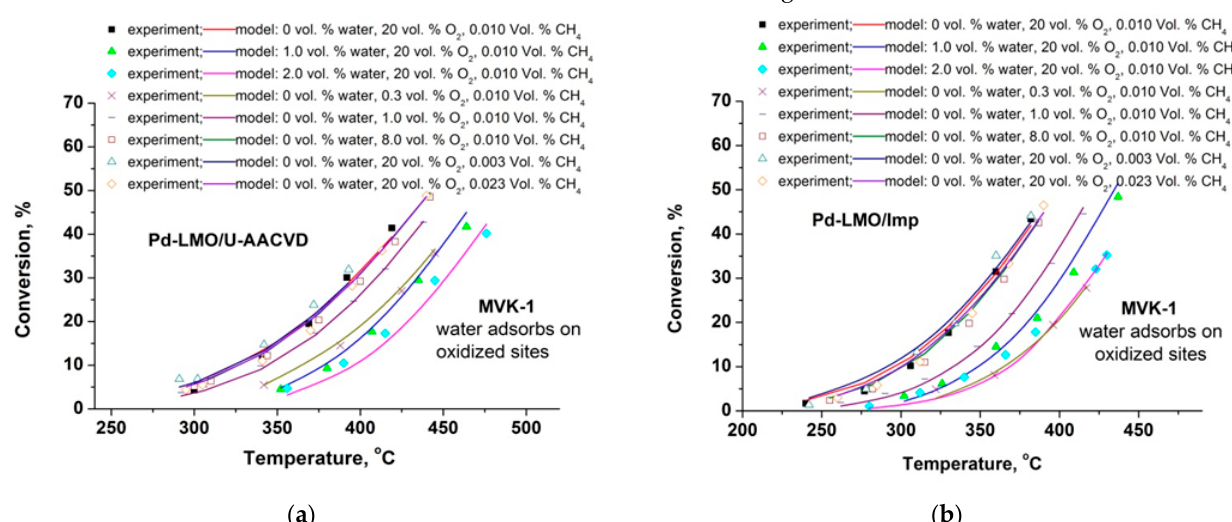
Figure 7. Temperature dependencies of the conversion degree of methane during the reaction of complete oxidation for catalysts obtained by the method of aerosol assisted chemical vapor deposition (U-AACVD) ( a ) and wet impregnation (Imp) ( b )—experimental results and predictions according to the best fitting model—Mars–van Krevelen, where the water molecules compete with the methane molecules for the oxidized active sites.